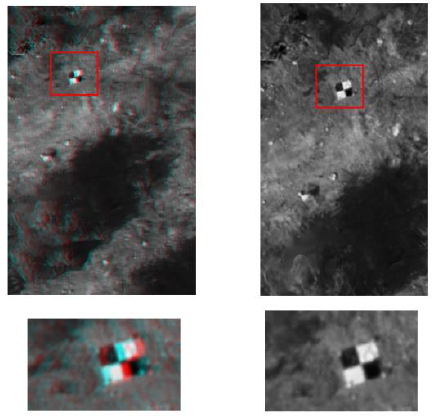
Figure 5. Before and after band-to-band